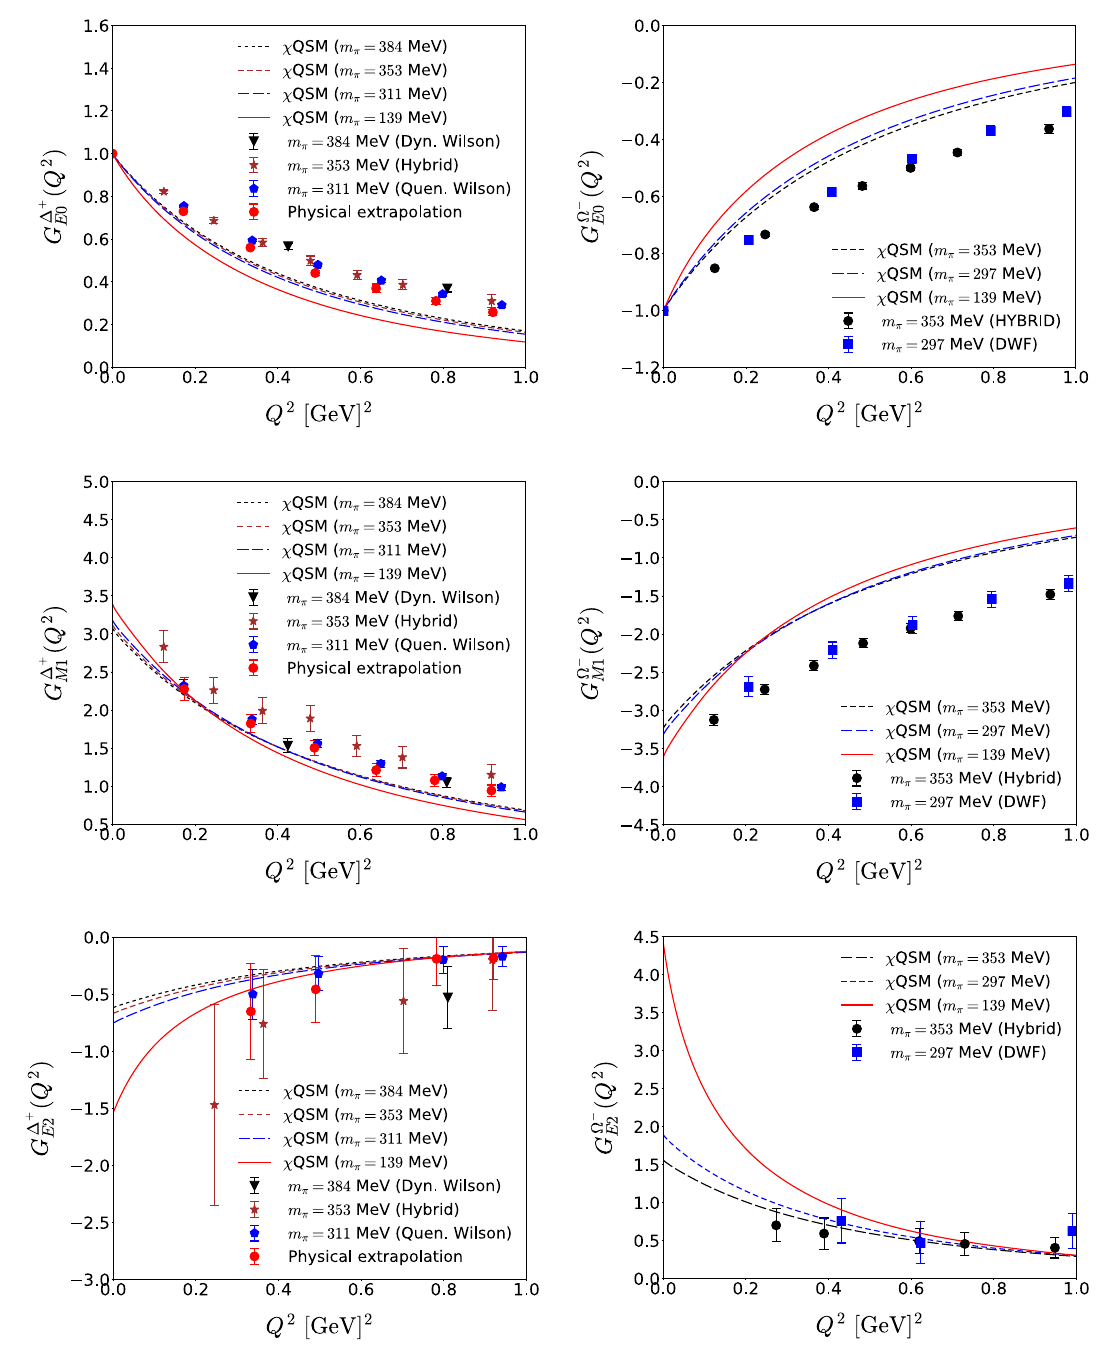
Fig. 13 Numerical results of the EM form factors of the (cid:2) + and (cid:5) − baryons with the different pion masses in the calculations of lattice QCD [21,23,24]